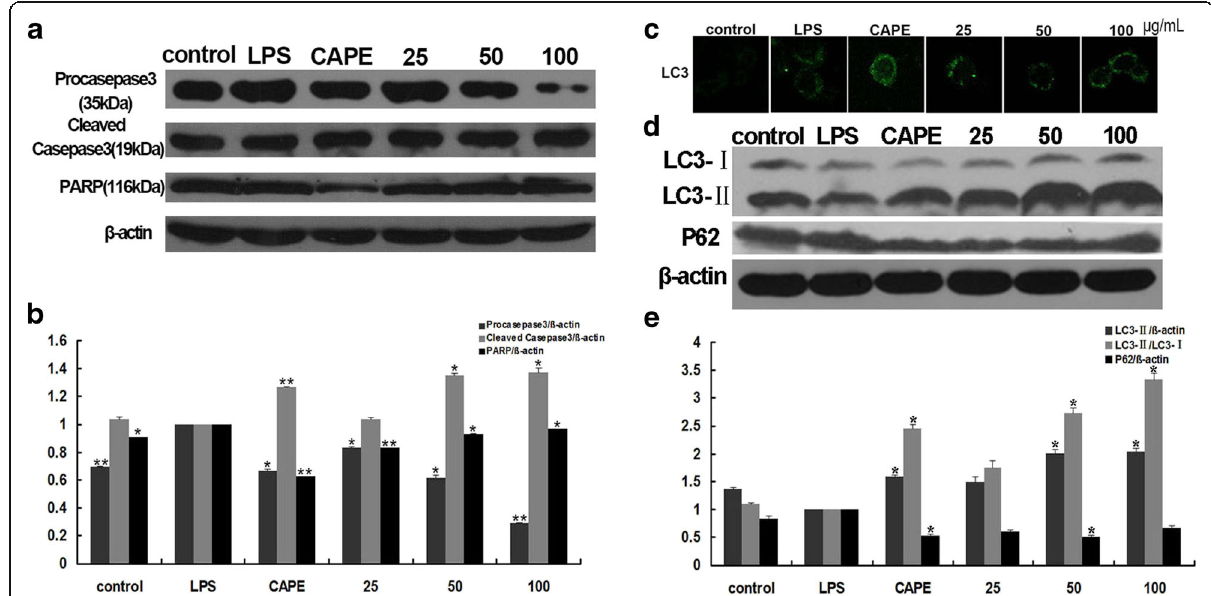
Fig. 5 EECP and CAPE induced apoptosis and autophagy in LPS-stimulated MDA-MB-231 cells. a The expression of caspase 3, procaspase 3 and PARP were detected by western blotting at 24 h. b Quantification of relative expression of procaspse 3, caspase 3 and PARP. c Cells were stained with anti-LC3B antibody for immunostaining. Immunofluorescence graphs showed an increase of endogenous punctuate LC3B. d The expression of LC3B and p62 were detected by western blotting at 24 h. e Quantification of relative expression of LC3-II, LC3-II/ LC3-Iand p62 in LPS- stimulated MDA-MB-231 cells. ( * P < 0.05, ** P < 0.01 vs control, n = 3). Data are means ±